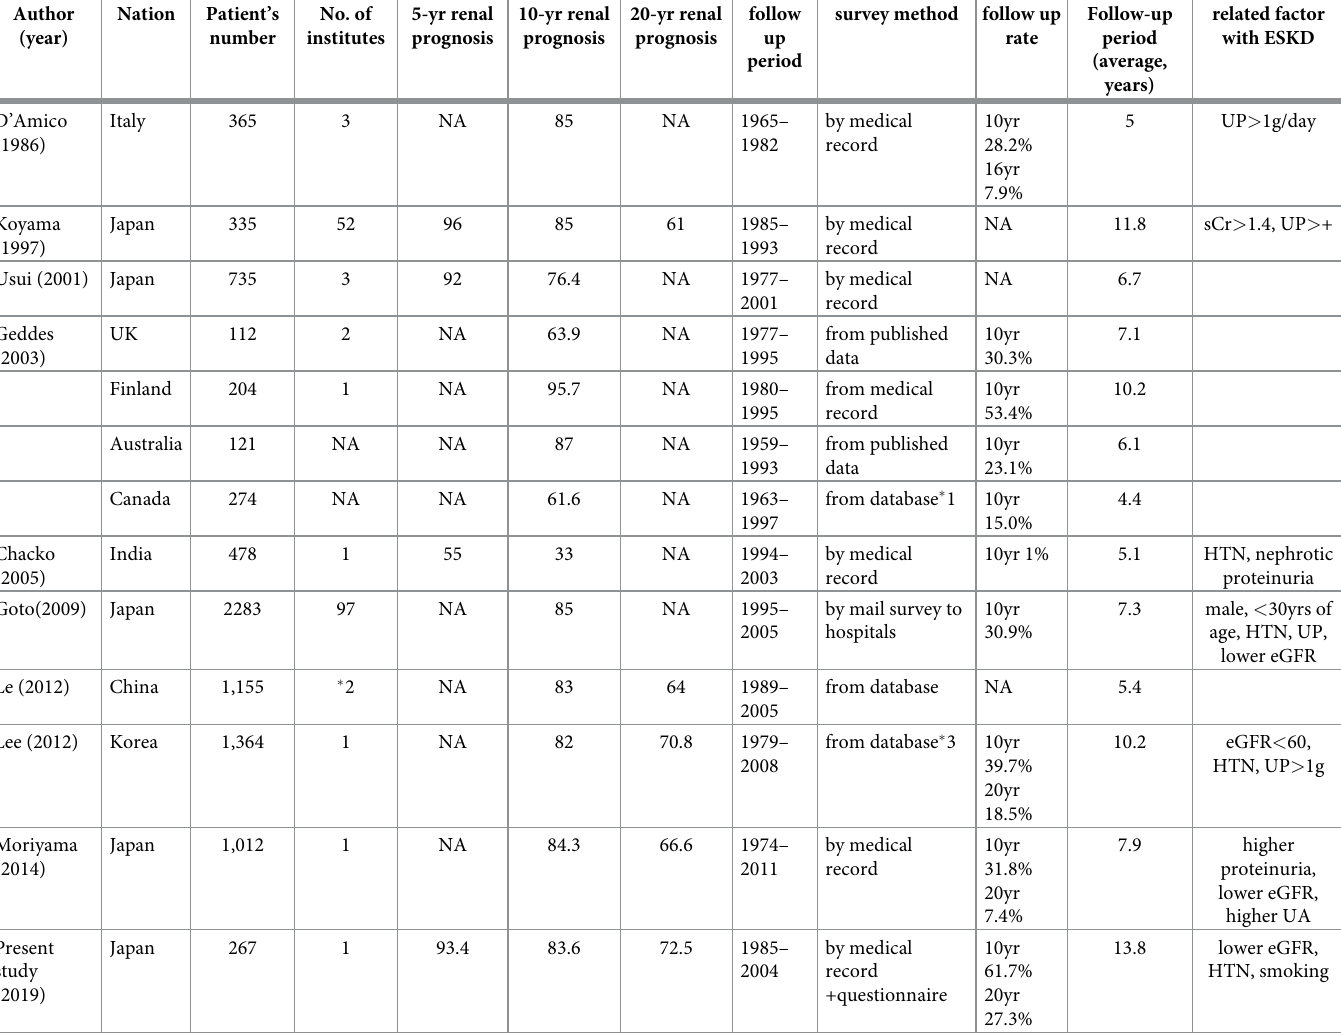
Table 4. Comparison among previous reports analyzed long-term renal outcome in patients with IgA